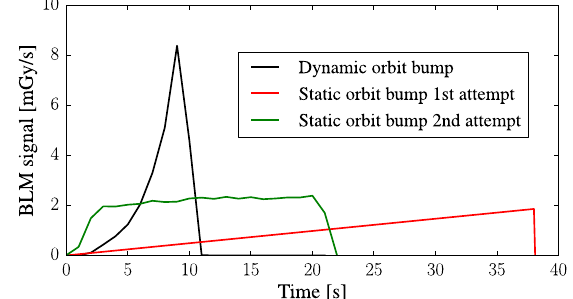
FIG. 19. Comparison of the highest BLM signal time profiles for the 2010 dynamic orbit-bump quench test and the 2013 static orbit-bump quench tests. Note that in 2013 static losses were only achieved in the second